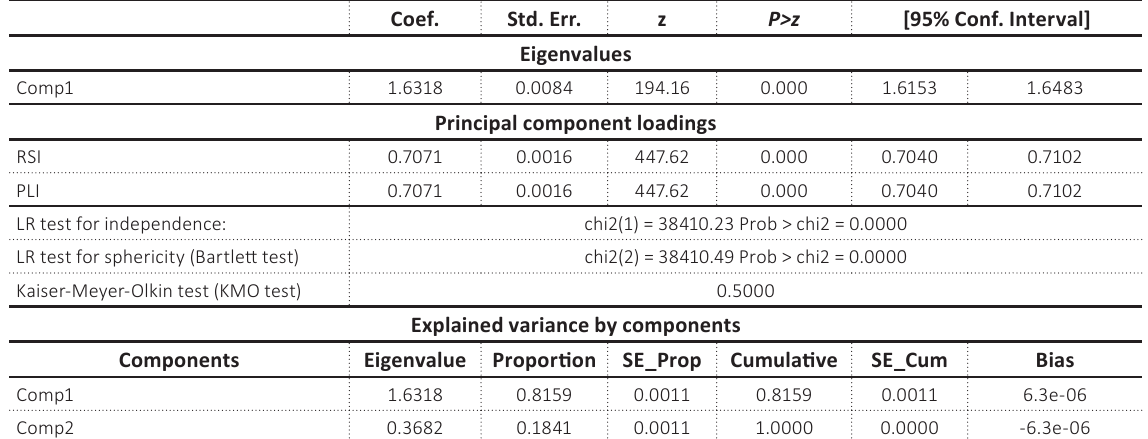
Table 3. Principal component analysis